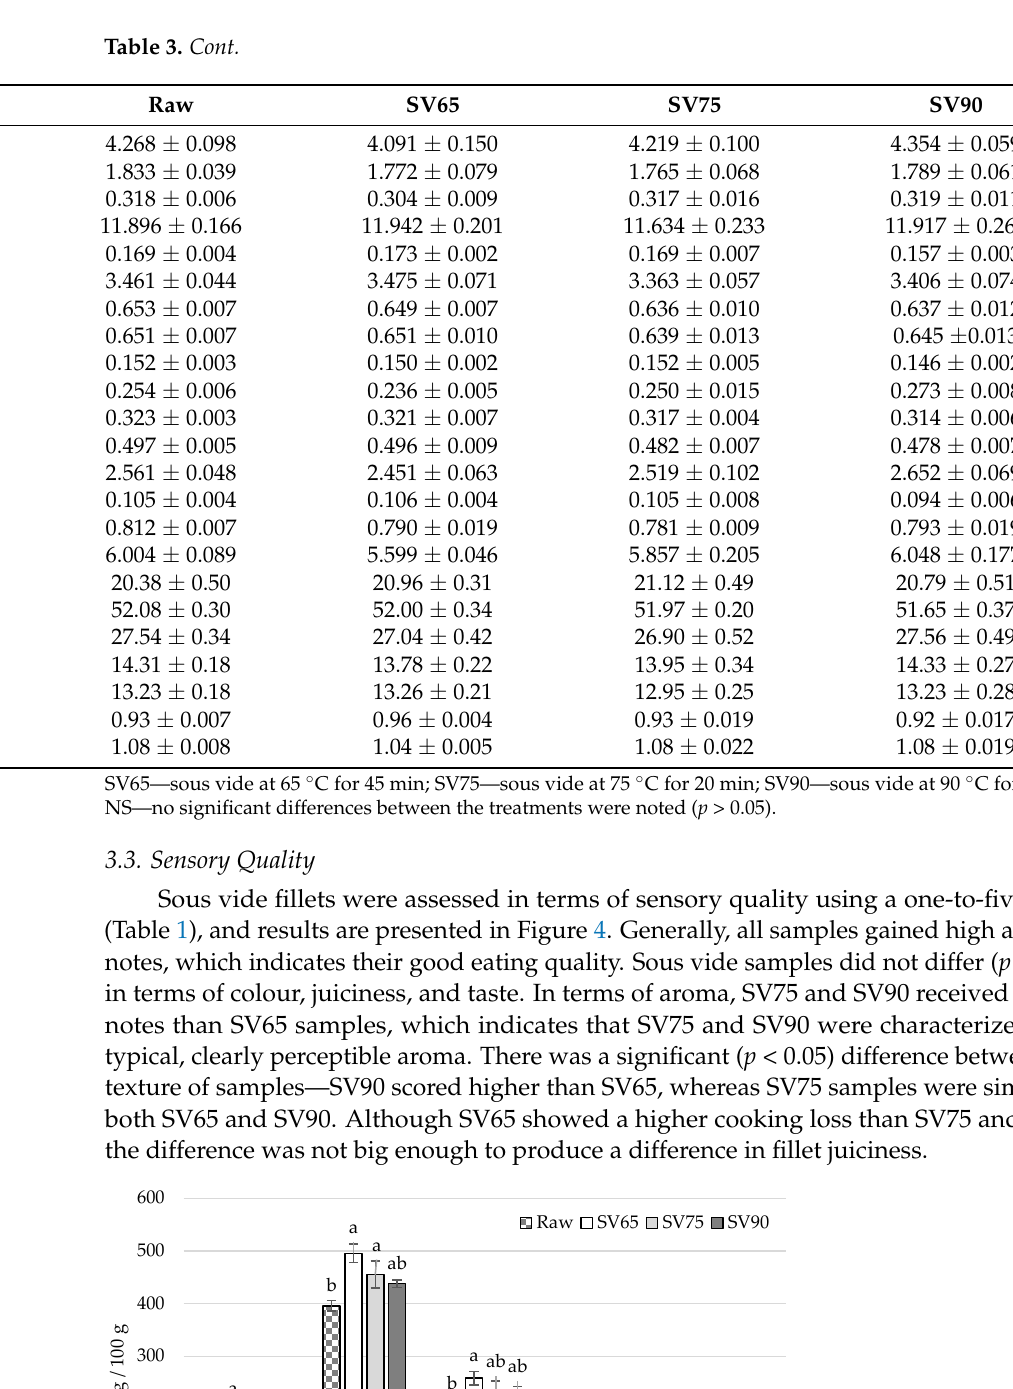
Figure 3. Comparison of fatty acids content (mg/100 g) in pikeperch fillets: raw and after sous vide treatment proceeded at 65 °C for 45 min (SV65), 75 °C for 20 min (SV75), and 90 °C for 10 min (SV90); vertical bars refer to standard error of the mean; a,b — values denoted with different letters differ significantly at p < 0.05; NS — no significant differences; EPA — eicosapentaenoic fatty acid; DPA — docosapentaenoic fatty acid; DHA — docosahexaenoic fatty acid. 3.3. Sensory Quality Sous vide fillets were assessed in terms of sensory quality using a one-to-five scale (Table 1), and results are presented in Figure 4. Generally, all samples gained high average notes, which indicates their good eating quality. Sous vide samples did not differ ( p > 0.05) in terms of colour, juiciness, and taste. In terms of aroma, SV75 and SV90 received higher notes than SV65 samples, which indicates that SV75 and SV90 were characterized by a typical, clearly perceptible aroma. There was a significant ( p < 0.05) difference between the texture of samples — SV90 scored higher than SV65, whereas SV75 samples were sim- ilar to both SV65 and SV90. Although SV65 showed a higher cooking loss than SV75 and SV90, the difference was not big enough to produce a difference in fillet juiciness.